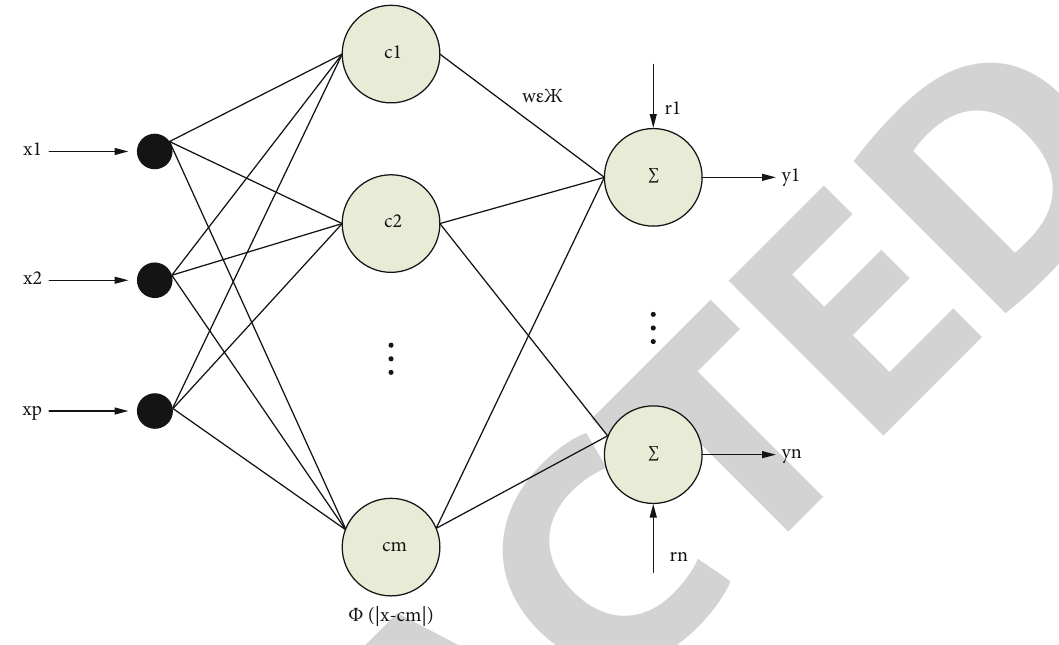
Figure 4: RBF net model topology structure diagram.